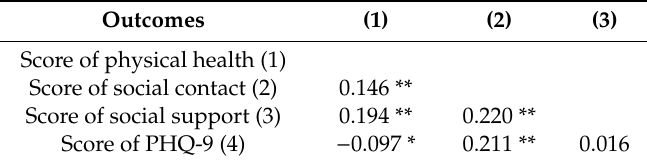
Table 6. Pearson correlations between changes in physical and social health and mental health